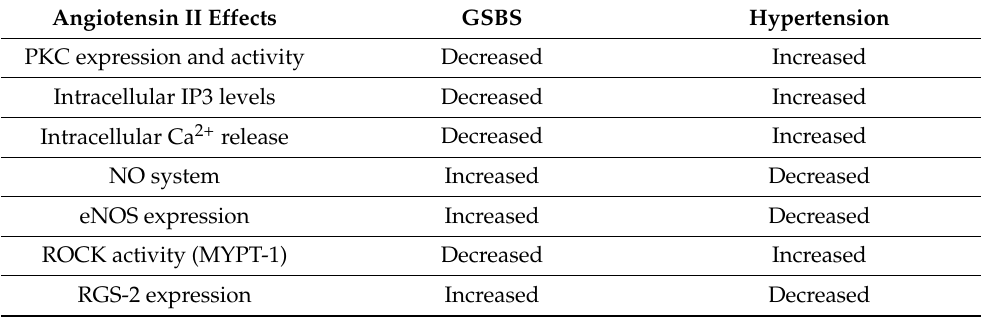
Table 2. Comparison between Ang II signaling effects on GSBS and